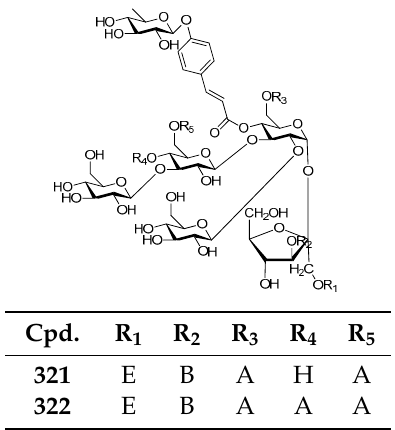
Figure 65. Structures of compounds 321 – 322